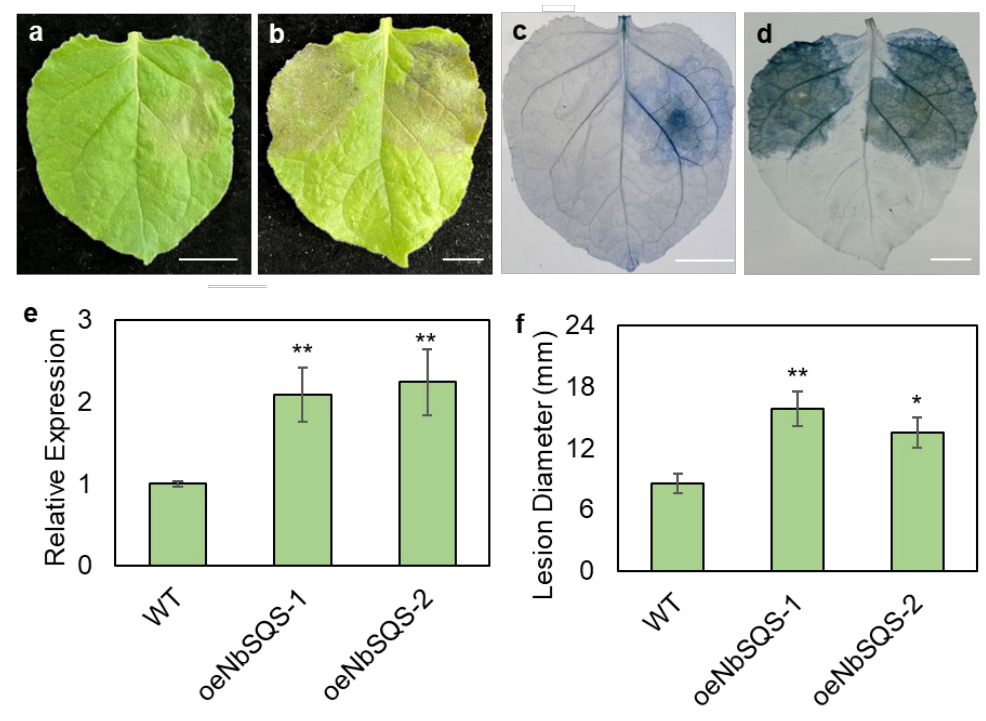
Figure 4. SQUALENE-SYNTHASE-overexpressing N. benthamiana plants are more susceptible to P. infestans. Symptoms of P. infestans inoculation on detached leaves of wild type ( a , c ) and oeNbSQS ( b , d ) plants under normal conditions ( a , b ) or after trypan blue staining ( c , d ). Scale bar ( a – d ) is 1 cm. Expression of NbSQS measured by q-RT-PCR; error bars = standard deviations ( e ). Lesion diameters on wild type and two independent oeNbSQS lines measured at 7 days post-inoculation; error bars = standard errors ( f ). Statistically significant differences from wild types calculated with Student’s t -tests (* p < 0.05, ** p < 0.01; N = 5 for q-RT-PCR; N > 24 for lesion diameter